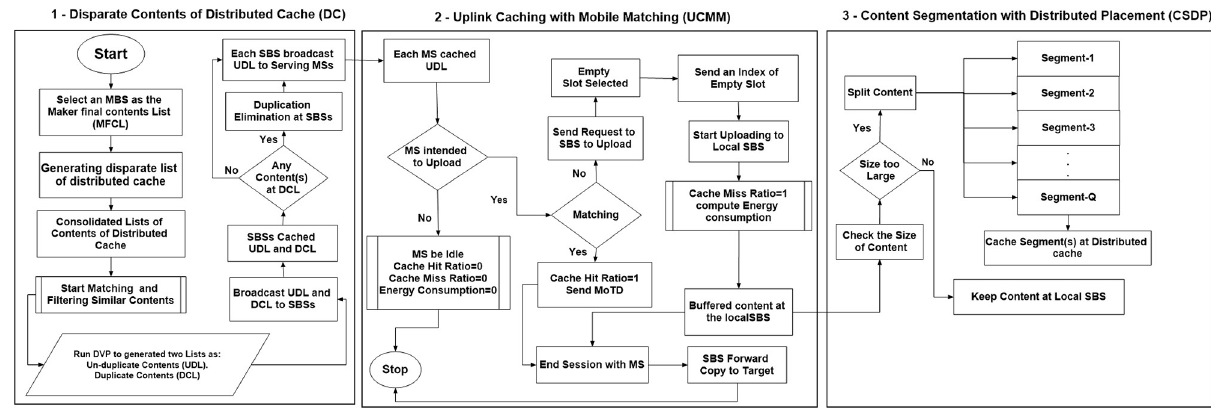
Fig 2. Proposed framework for distributed uplink caching.